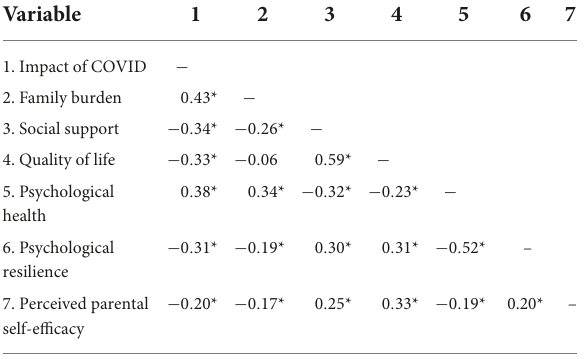
TABLE 3 Bivariate correlations among